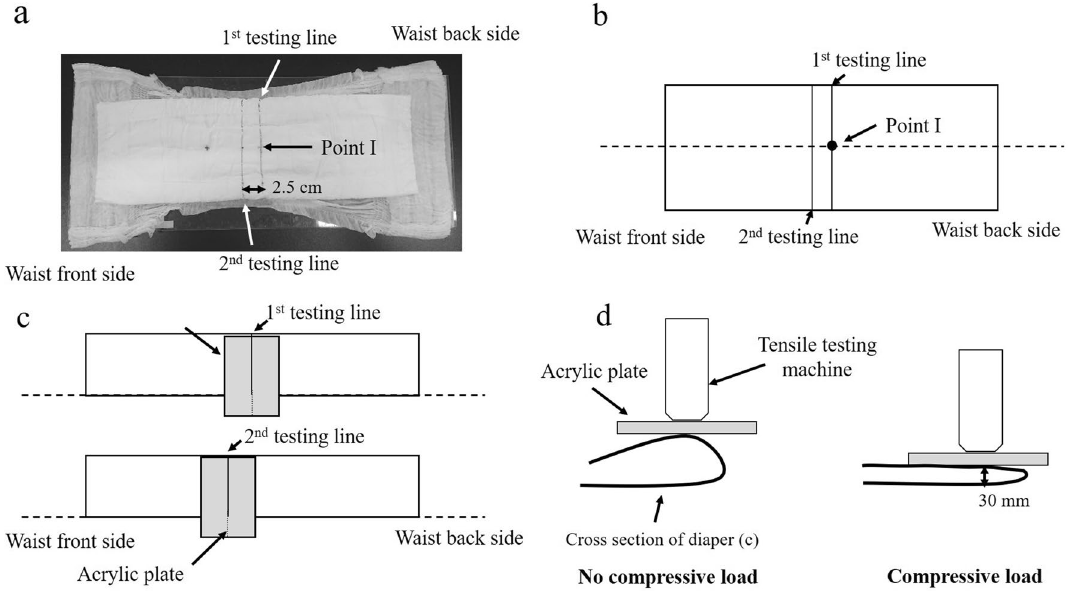
Figure 5. Method for measuring bulk stress. ( a ) The diaper was opened, extended fully, and marked with two straight lines. ( b ) The diaper was folded to half size along the dotted line as illustrated. ( c ) A rectangular acrylic plate was placed on the diaper. ( d ) The center of the plate was compressed vertically downward by a tensile testing machine at a speed of 100 mm/min until the thickness of the diaper decreased to 30